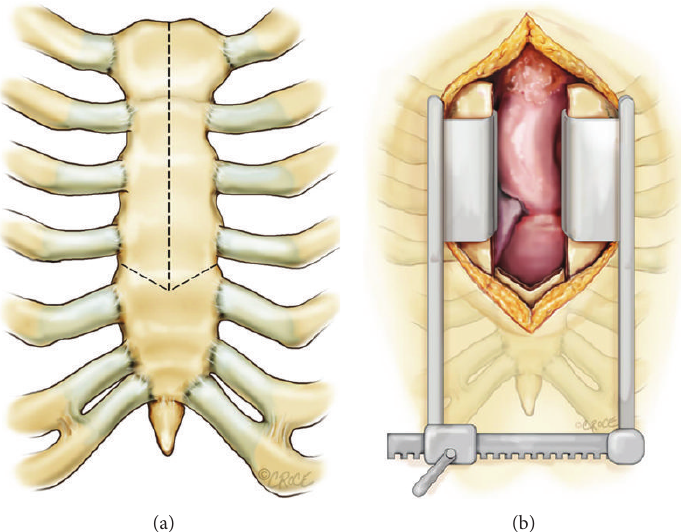
Figure 1: Markings made prior to opening the sternum (a); typical access through an arrowhead ministernotomy incision (b).